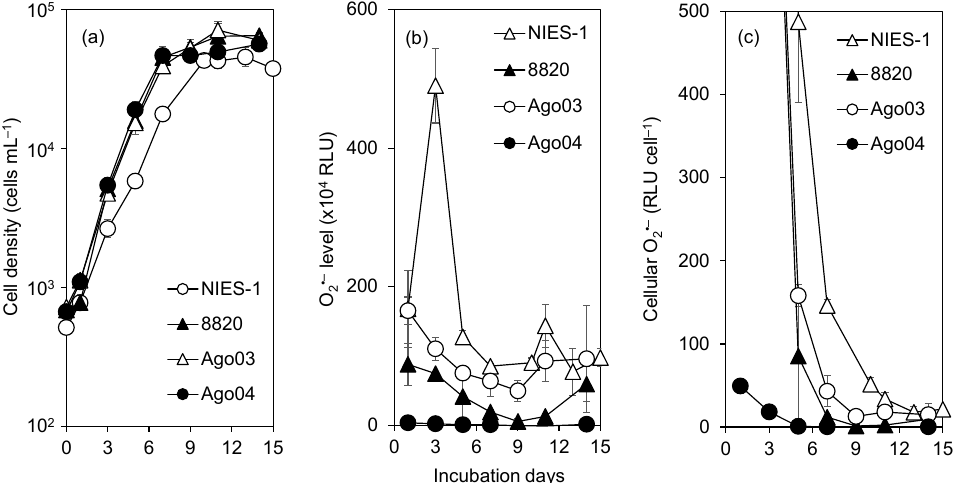
Figure 6. Time-course variations in cell density ( a ), superoxide (O 2 •− ) level in culture ( b ), and cellular O 2 •− production level ( c ) in two highly toxic (Ago03 and NIES-1) and two low-toxicity (Ago04 and 8820) Chattonella strains. Data points in each plot represent the mean ± SD of triplicate measurements. RLU, relative luminescence units. This experiment was conducted in the absence of fish.